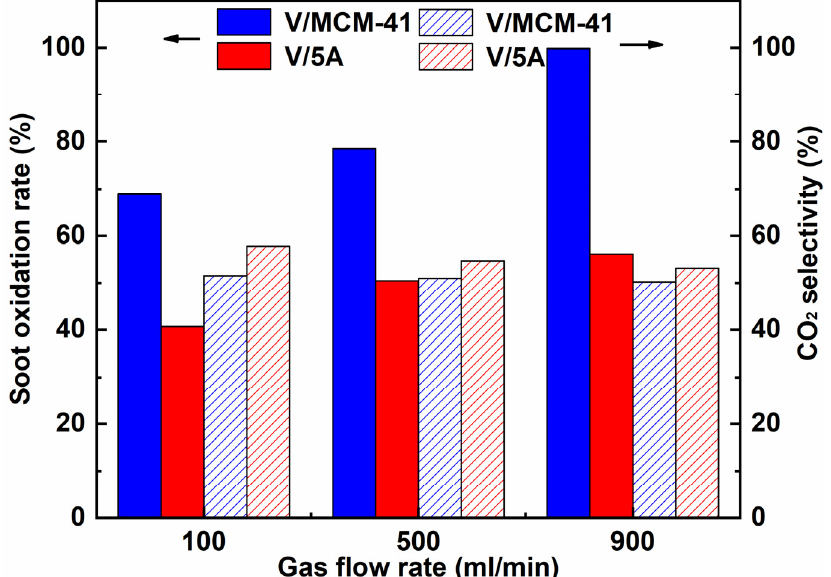
Figure 7. Effect of gas flow rate on soot oxidation rate and CO 2 selectivity of plasma-catalytic soot oxidation at 30th min over V/MCM-41 and V/5A catalysts (Discharge power: 20 W and reaction temperature: 25 °C).